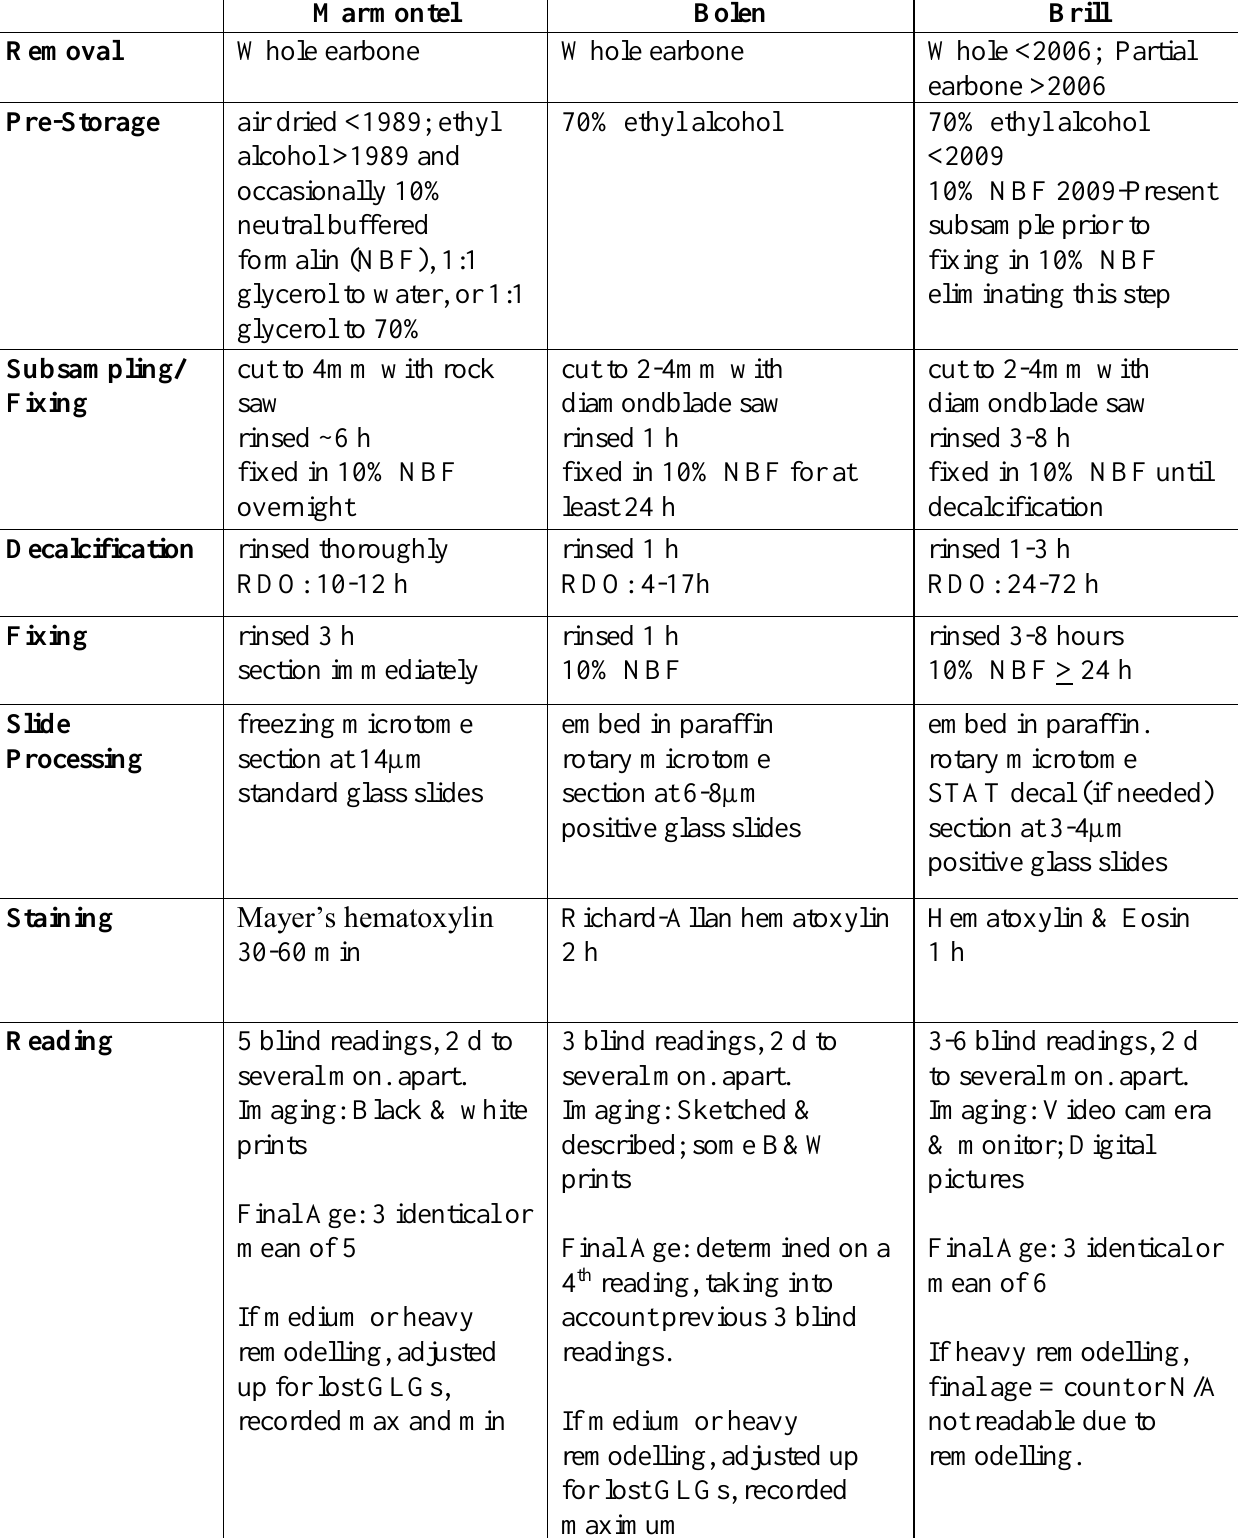
Table 1. Methods used by researchers in preparing manatee earbones for age determination. Marmontel Bolen